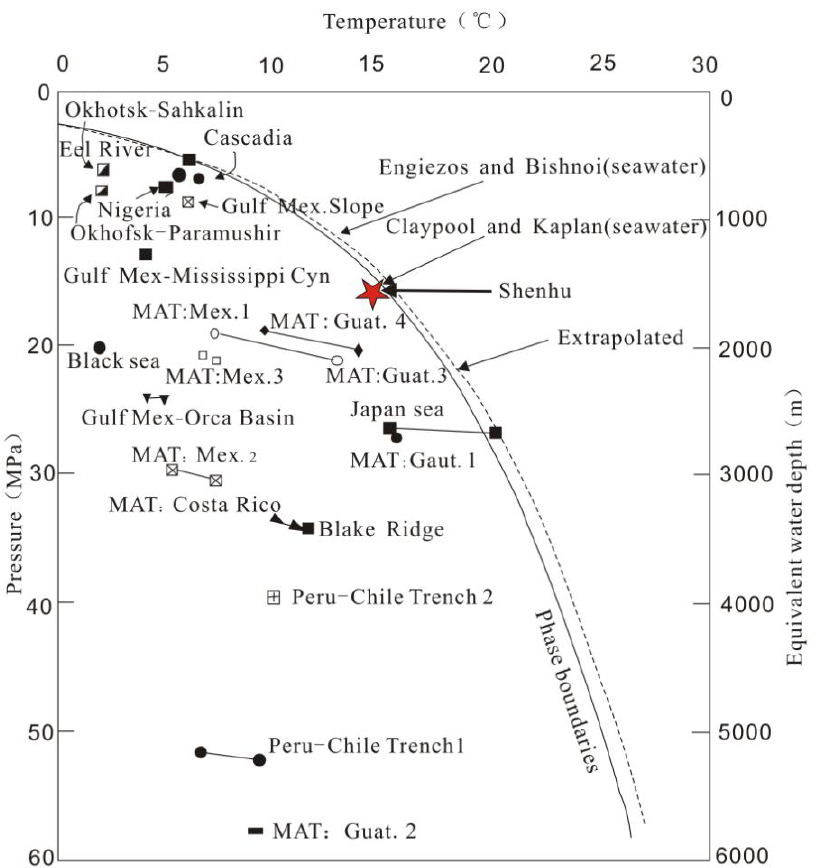
Figure 5. Compilation of data for recovered hydrate samples in relation to the three phase boundary (modified from Booth et al. , [48], quoted in Reference